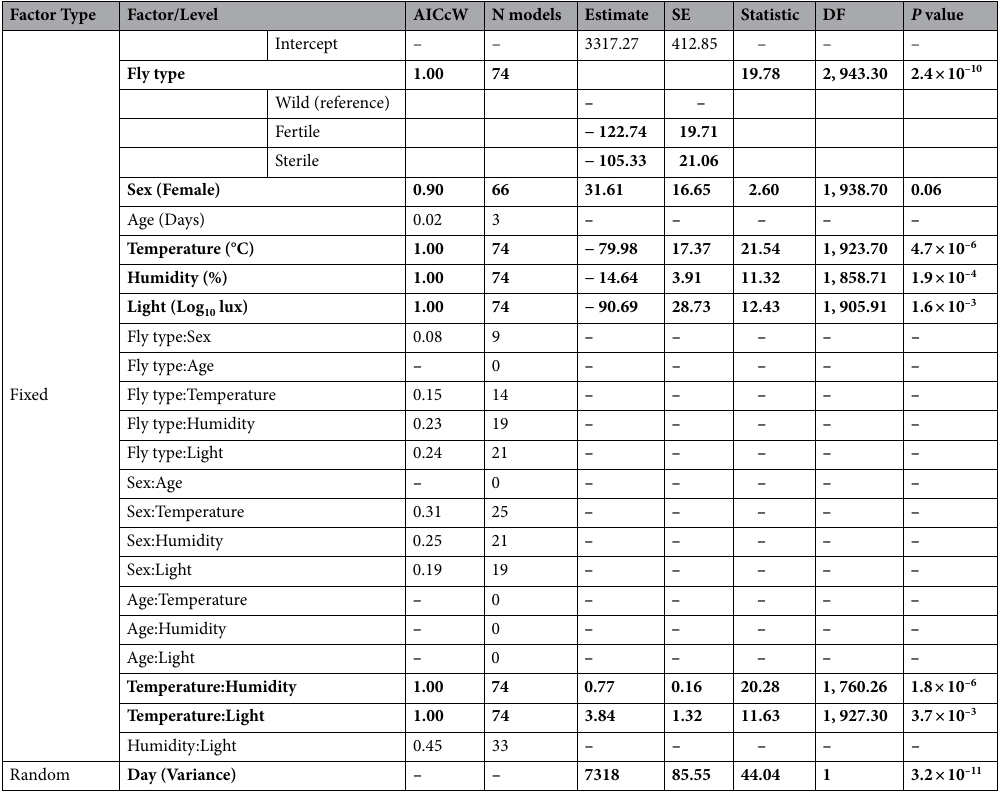
Table 1. Mixed-model results for the best model (AICc min ; bolded) with height (mm) as response variable. The sum of weights for the corrected Akaike Information Criterion (AICcW) and N models (total = 74) with AICcΔ < 4 for each factor are summarized here. Intercept has reference level Wild Male. The significance of fixed factors was assessed using F-statistic in a type III ANOVA with Satterthwaite’s method. The random factor was assessed using log-likelihood ratio with significance analyzed using a chi-square